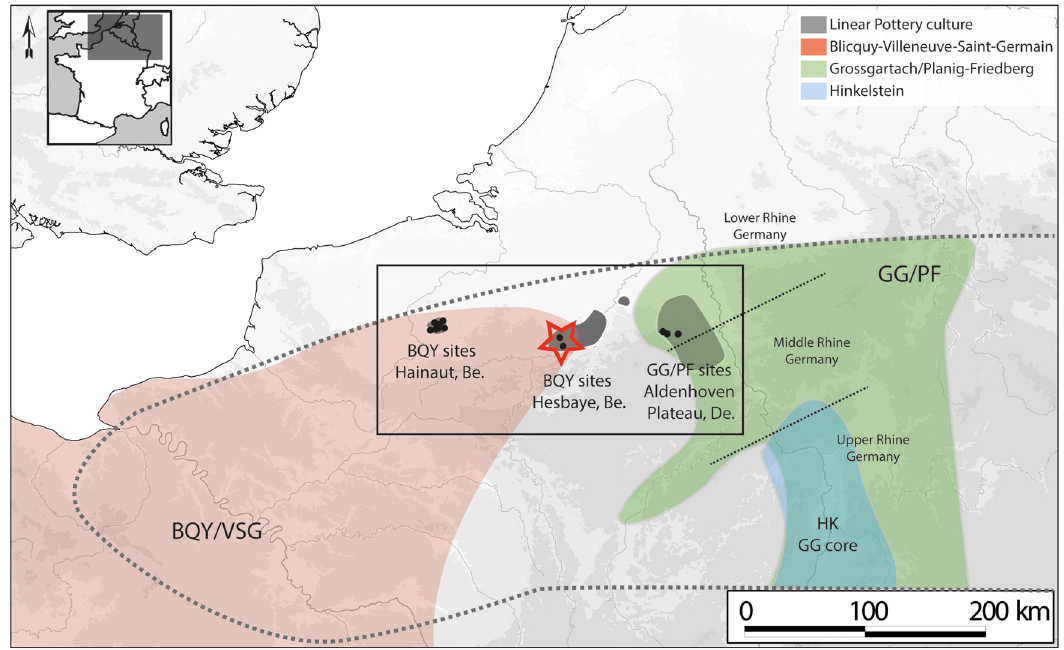
Figure 1: Map of the studied region. The red star indicates the geographical area in question ( part of Hesbaye region in Belgium ) . The red dot is the key site of this study, Vaux - et - Borset, while the post - Linear Pottery culture sites indicated in black served as points of comparison and are representing the three clusters under study. The grey dotted lines mark the maximum extension area of the Linear Pottery culture, while the regional concentrations for our study area ( framed in black ) are indicated by grey solid